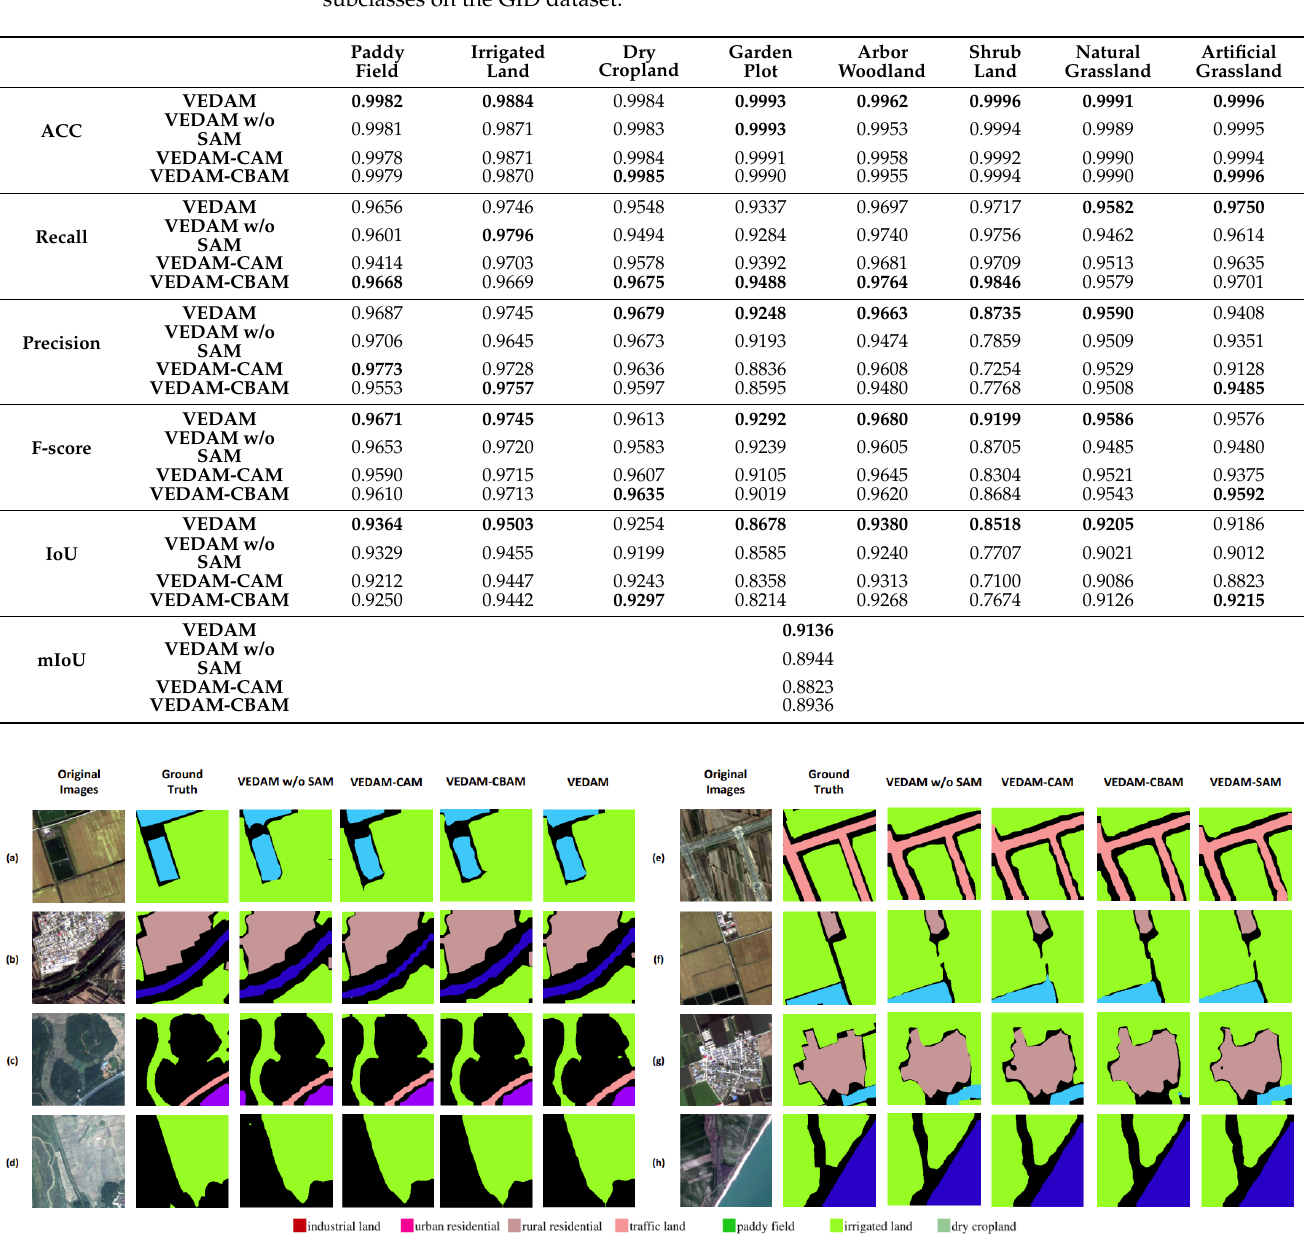
comparison models. The vegetation results extracted from the original model and the other two network models inevitably have the problems of misclassification and omission. Table 7. Comparison results of VEDAM combined with different attention modules on 8 vegetation subclasses on the GID dataset.